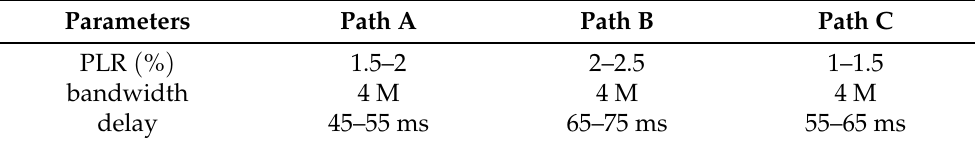
Table 5. Link configurations.